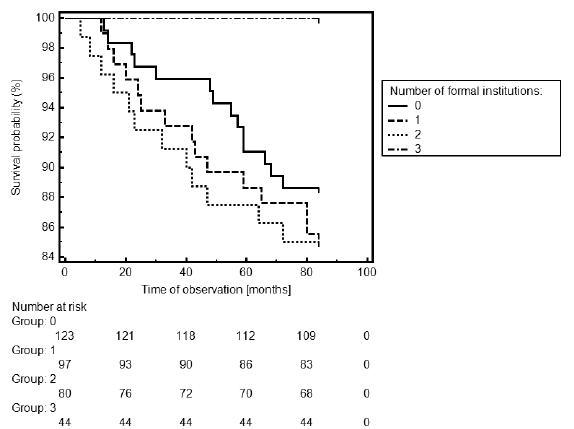
Figure 2. Kaplan-Meier curves for different number of formal institutions pointed out by managers as obstacles to the development of their companies (source: own